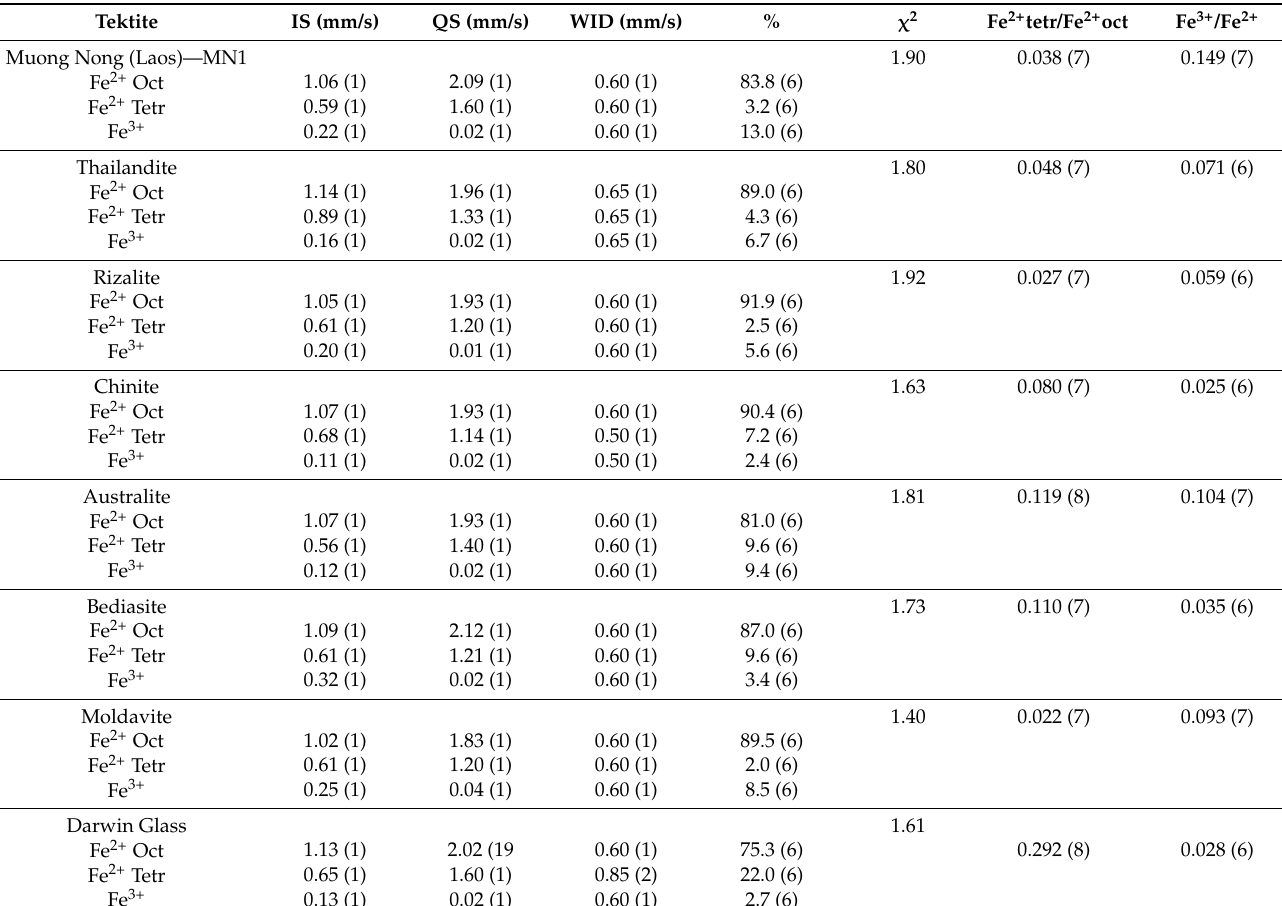
Table 8. Average hyperfine parameters obtained from the fitting procedure to spectra shown in Figure 20 for the different strewn fields. Errors in last significant digits are given in brackets.